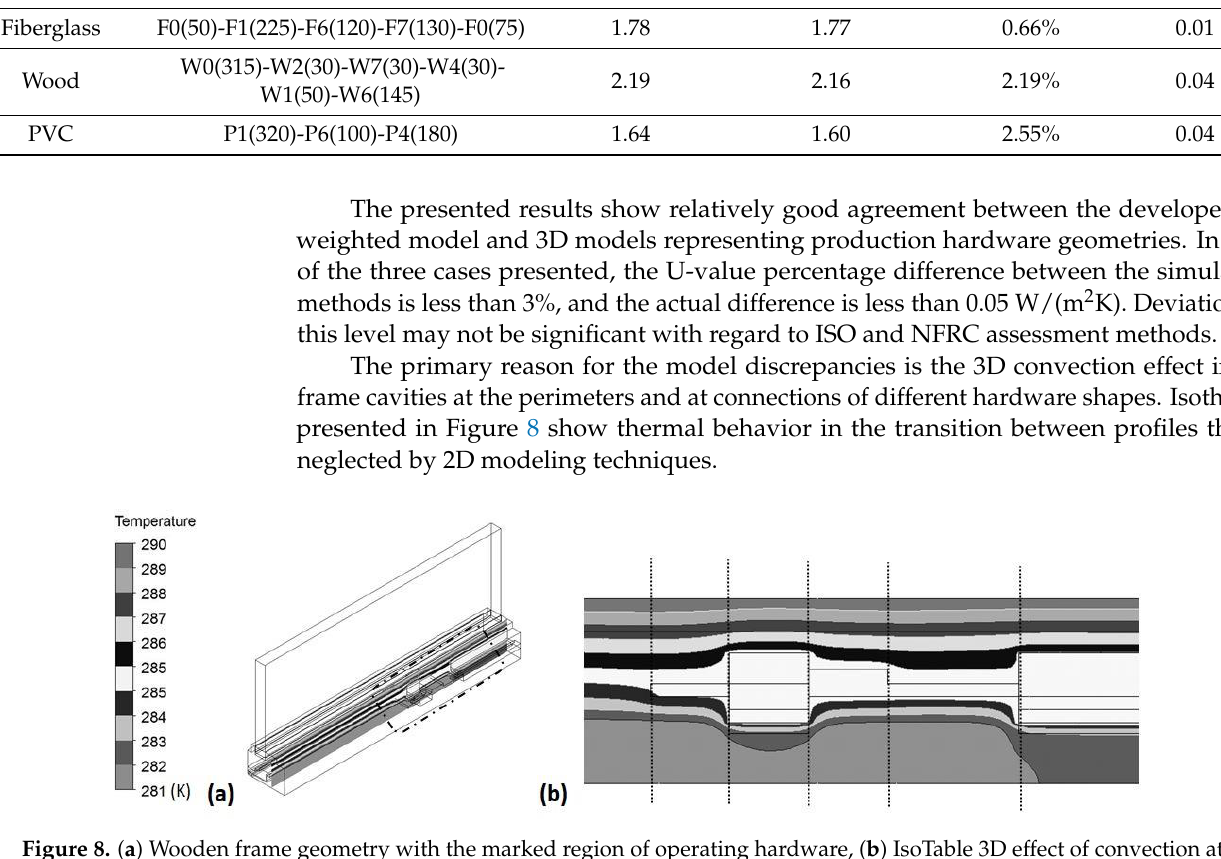
Figure 8. ( a ) Wooden frame geometry with the marked region of operating hardware, ( b ) IsoTable 3D effect of convection at the hardware geometry